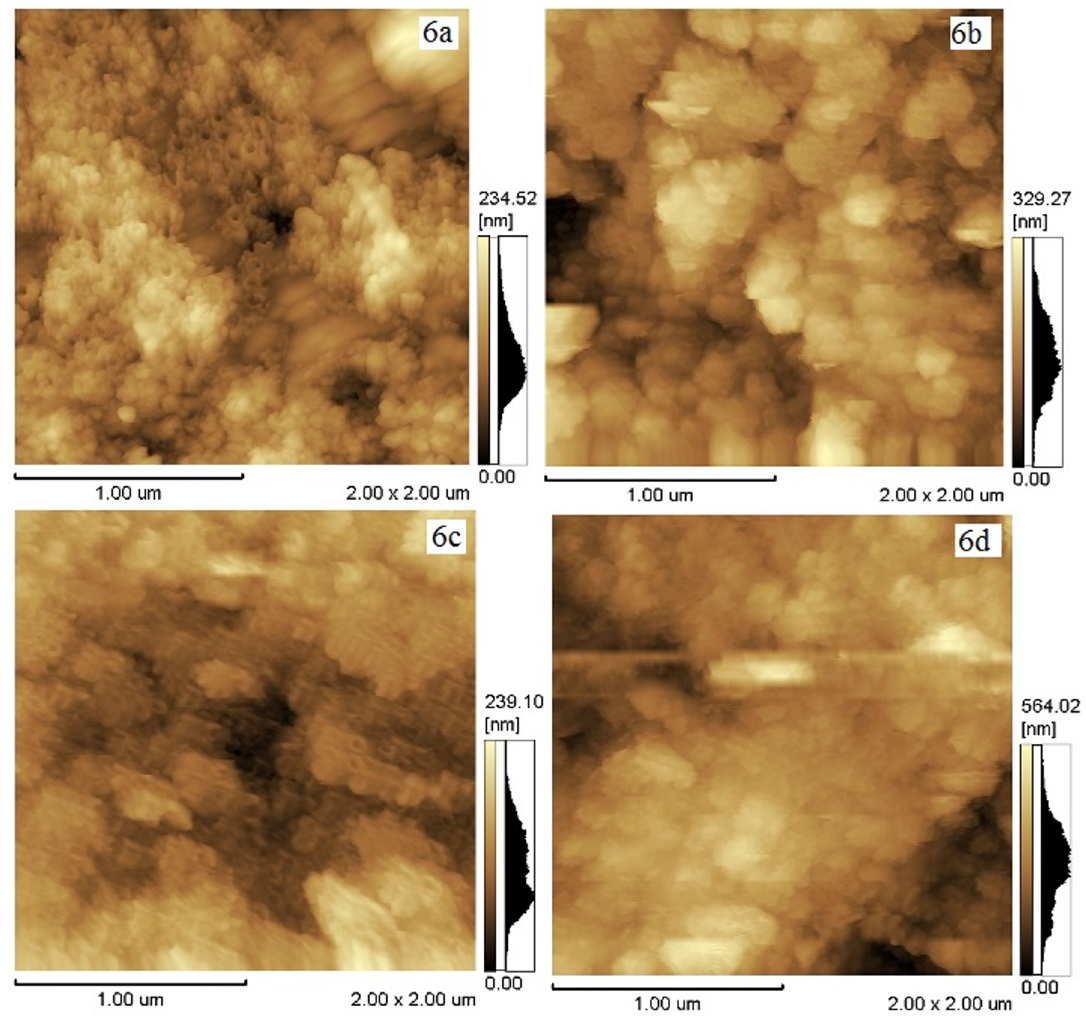
Figure 6. AFM images of the Ti-7.5Mo alloy after anodization at 20V and 30V and calcined at 600 ºC: for 24 hours (5a and 5c) and for 48 hours (5b and 5d)